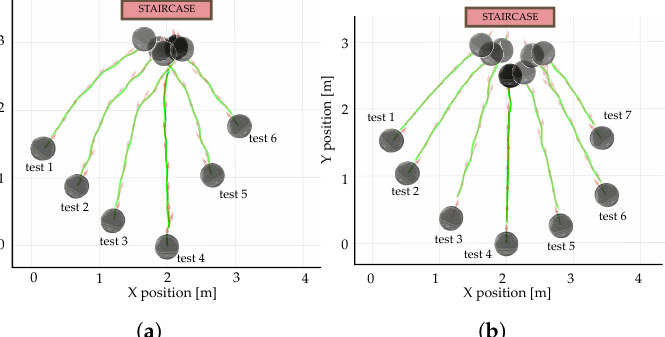
Figure 12. Staircase approach and alignment paths obtained using the Fuzzy Logic Controller: ( a ) tests done with staircase 1, ( b ) tests done with staircase